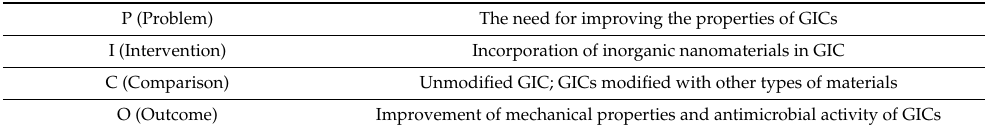
Table 2. Definition of PICO strategy applied for the present